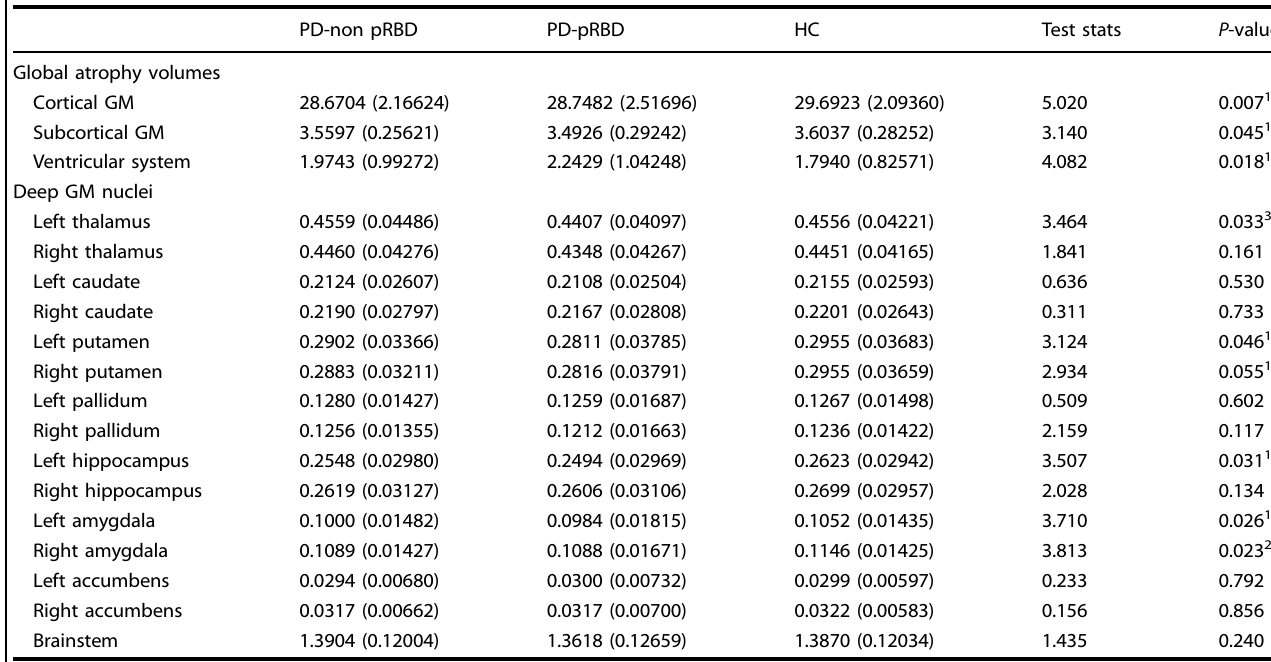
Table 2. Global and partial volume ratios of PD-non pRBD, PD-pRBD, and